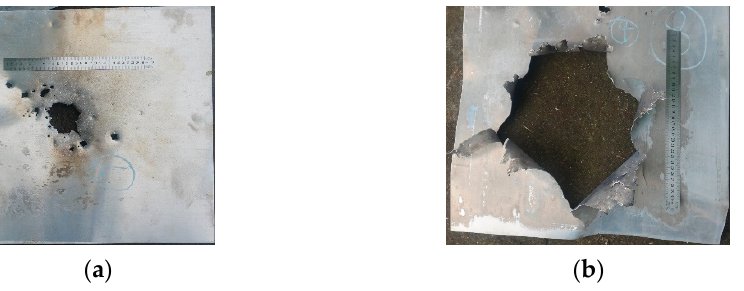
Figure 12. Damage of two kinds of projectiles to the aluminum target plate: ( a ) No. 7, conventional projectile; ( b ) No. 8 PELE projectile filled with reactive material.